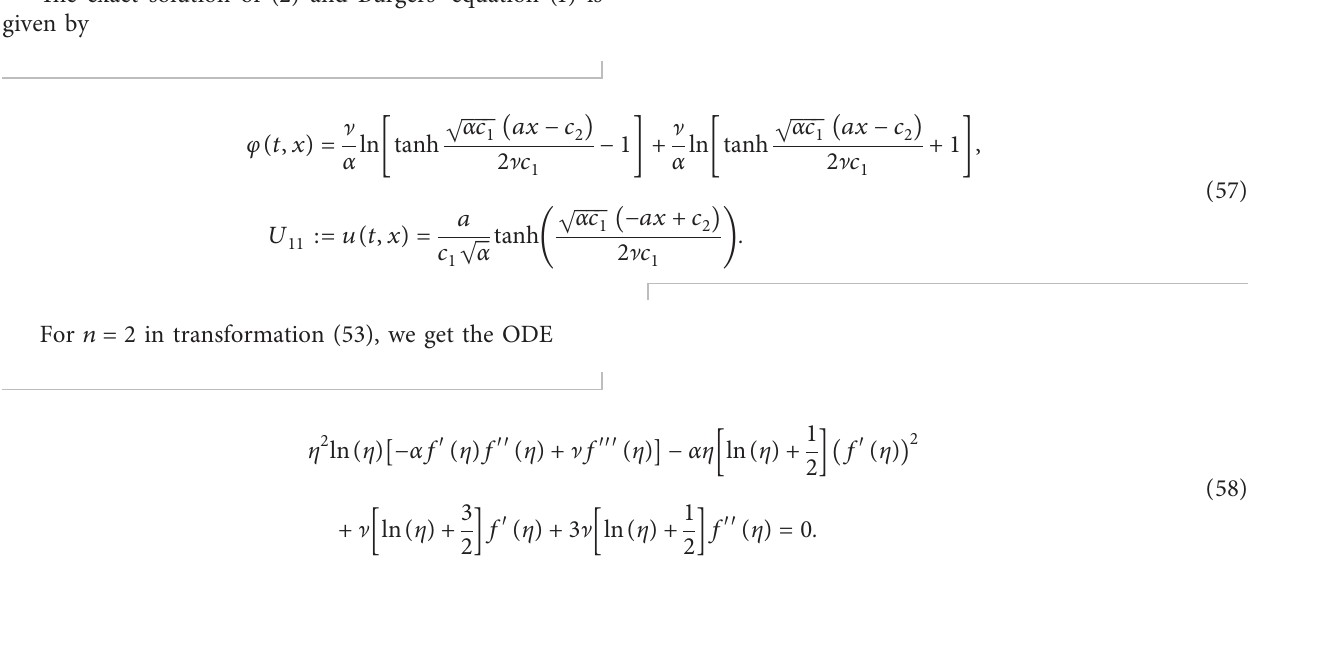
given in (60) for a � − 1, α � 1, and ] � 12